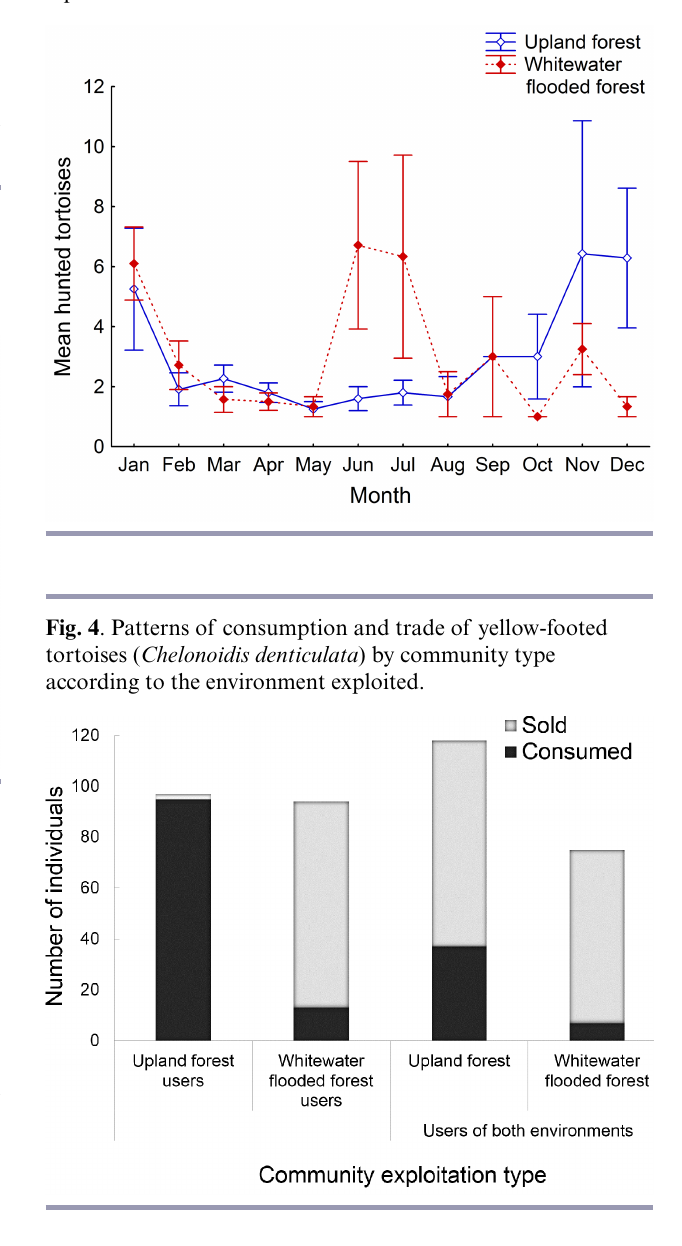
Fig. 3 . Mean of captures of tortoises per month over the 12 years of hunting monitoring in upland forests and in whitewater flooded forests in the Brazilian Amazon. Bars represent standard errors.